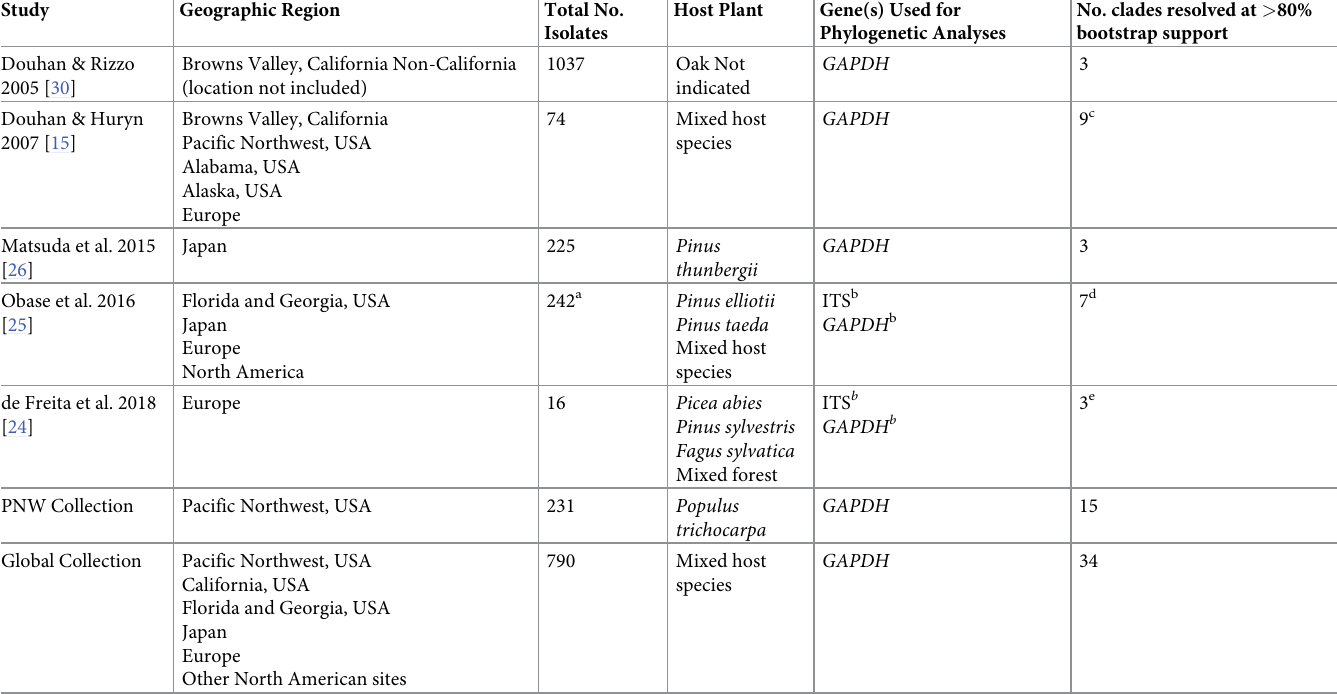
Table 2. Previously resolved clades per study, number of isolates, geographic region, and host plant. The Pacific Northwest (PNW) isolate collection resolved 15 clades which appear to be uniquely associated with Populus trichocarpa within its host range in the